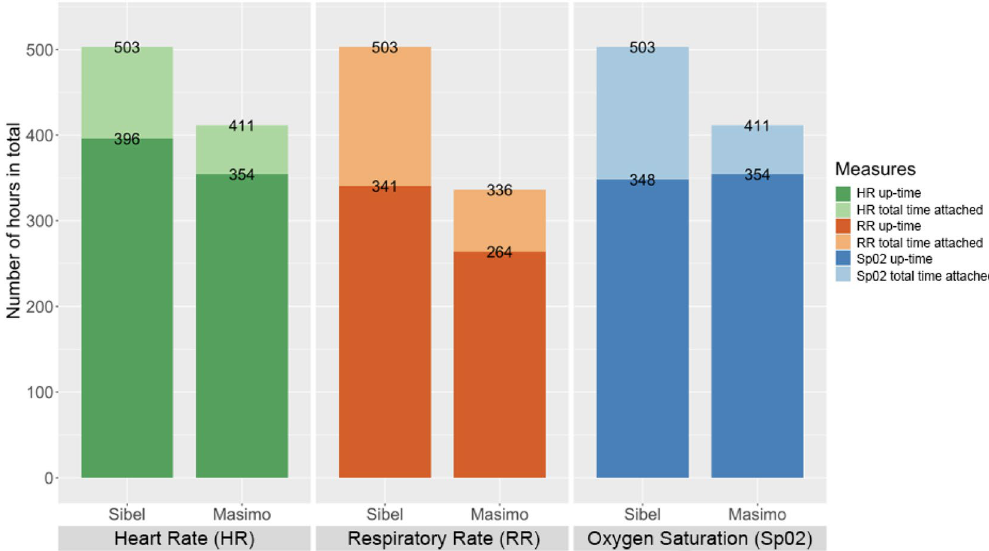
Figure 1. Total time technology attached and up-time.